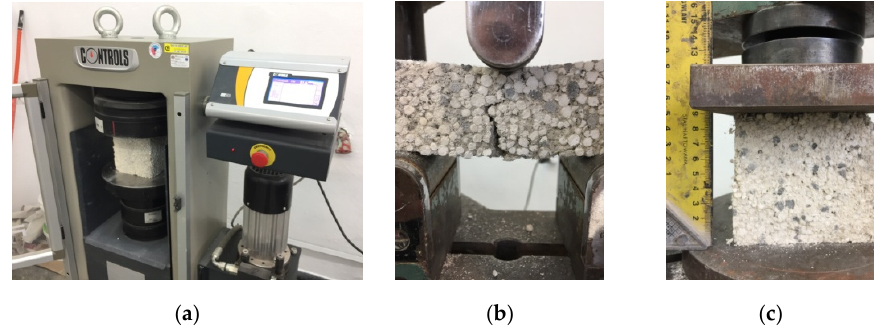
Figure 6. Strength tests: ( a ) compressive strength; ( b ) bending tensile strength; ( c ) for compressed cubes 10 × 10 × 10 cm, the force was also determined with a 10 mm shortening.